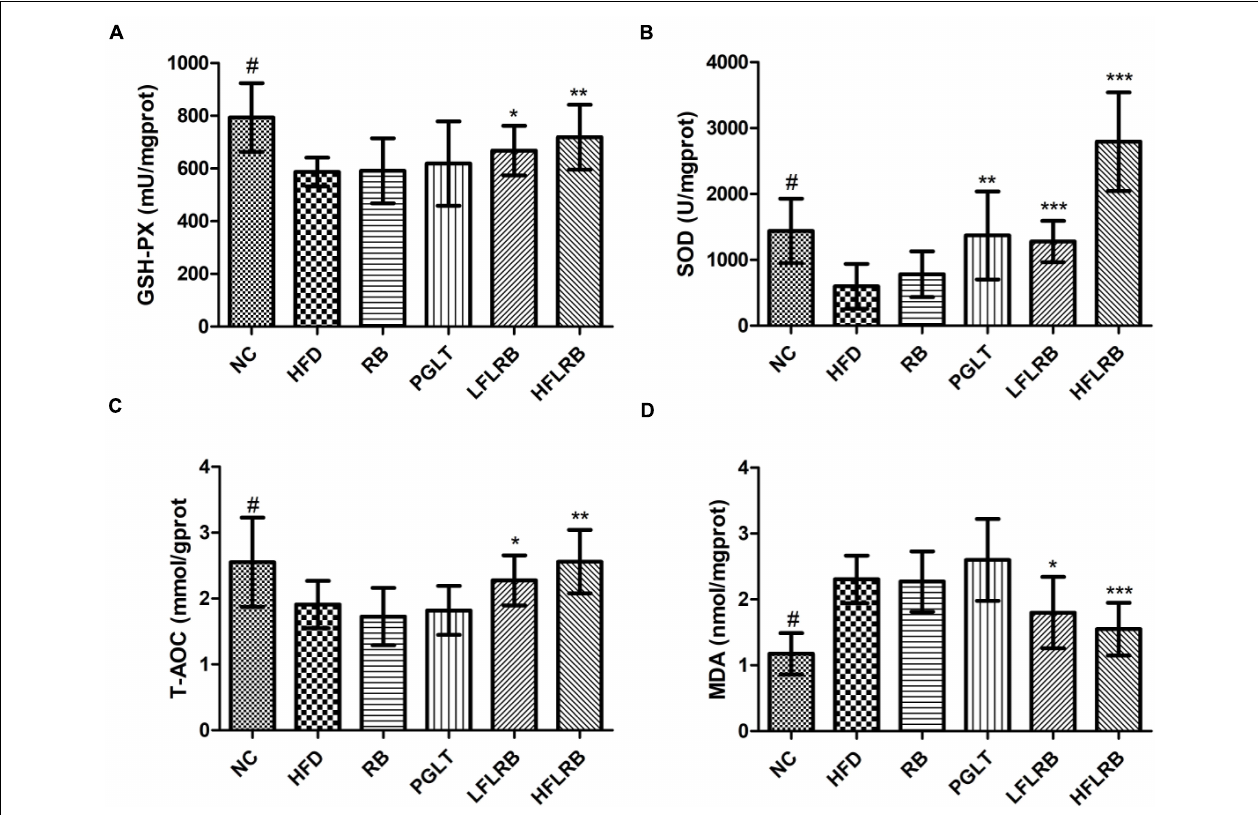
FIGURE 4 | Effects of FLRB on the antioxidant activity in the livers of mice. (A) Glutathione peroxidase (GSH-PX), (B) Superoxide dismutase (SOD), (C) total antioxidant capacity (T-AOC), (D) malondialdehyde (MDA). Values are expressed as the mean ± SD ( n = 10). # and *** represent P < 0.001, ** represents P < 0.01, * represents P < 0.05, compared to the